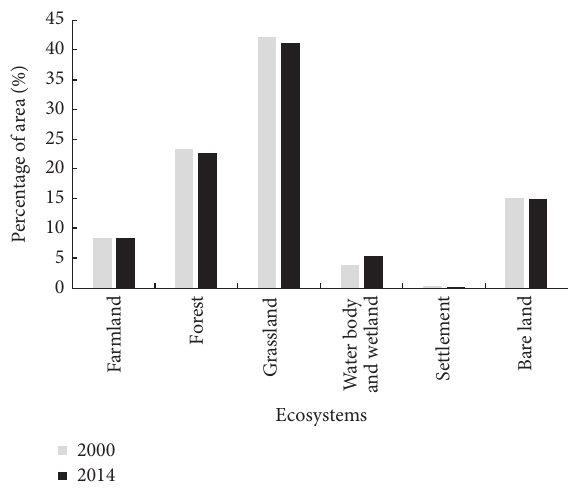
Figure 2: The area proportion change of ecosystems in